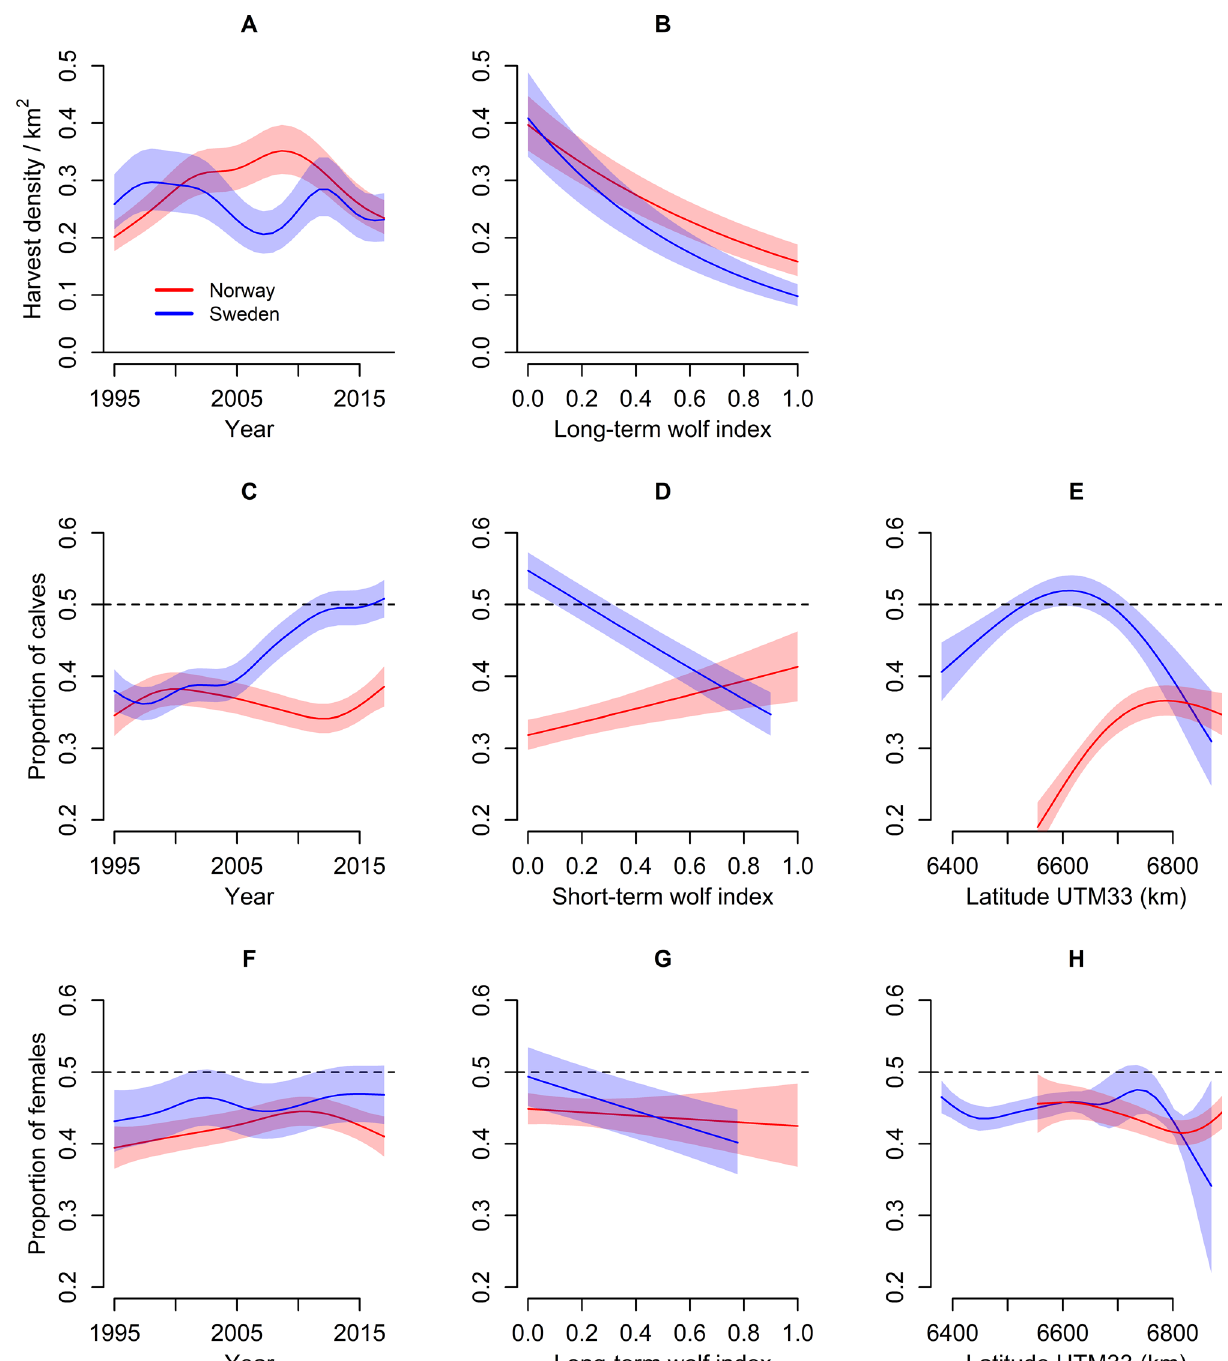
Figure 1. Predicted density (per km 2 ) of harvested moose ( A , B ), proportion of calves in total harvest ( C – E ), and proportion of females in adult harvest ( F – H ) in Norwegian (red) and Swedish (blue) moose management units from 1995 until 2017 ( A , C , F ), average annual wolf territory density during the last 5 years (long-term wolf index) or 2 years (short-term wolf index) ( B , D , G ), and latitude ( E , H ). The predictions show average and 95% confidence intervals and are from generalized additive mixed models (GAMM) without the random factor (ID of management unit). Reference values were year 2012, wolf index 0.25, and latitude 6700 km. Dashed line represents an equal proportion of harvested calves and adults ( C – E ) and adult females and males ( F – H